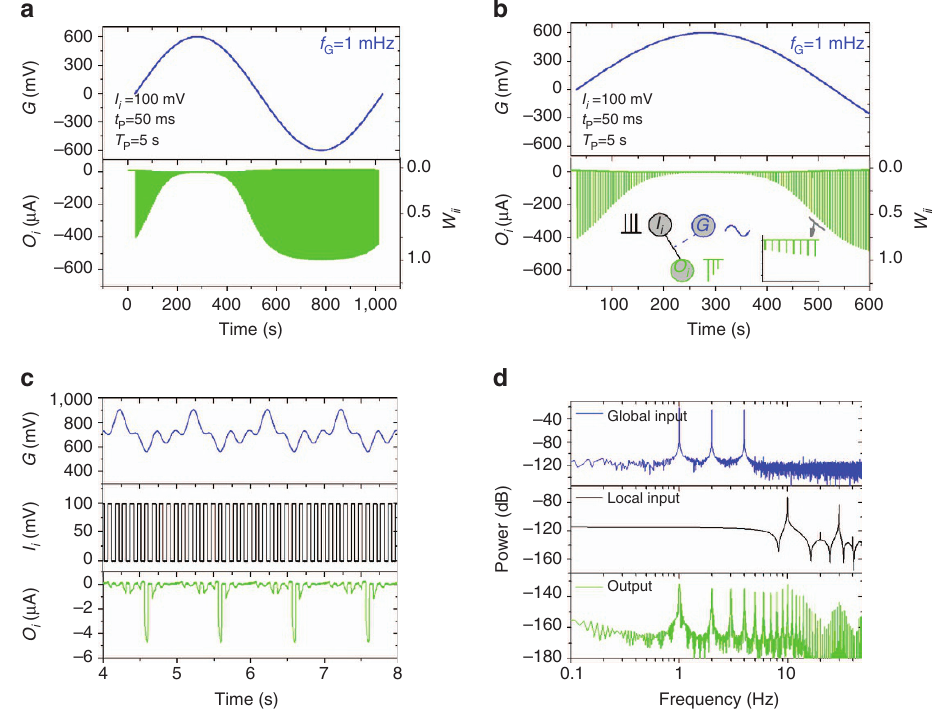
Figure 3 | Global input as a global clock. ( a , b ) Periodic modulation of the output caused by a train of voltage pulses (amplitude of 100mV, width of 50ms, period of 5s) at a local input, and a sine wave (amplitude of ± 600mV, frequency of 1mHz) at the global input, shown here for a full period ( a ) and for the positive half of the cycle ( b ). ( c ) Global input with higher harmonics (amplitude modulation of a sine wave of frequency of 1Hz, amplitude of 180mV and offset of 700mV, with a second sine wave of frequency of 3Hz, AM depth of 120%), and a train of voltage pulses (amplitude of 100mV, width of 50ms, period of 100ms) at local input results to an output that contains predominantly the low-frequency components of the global input. ( d ) Power spectra of G , I i and O i